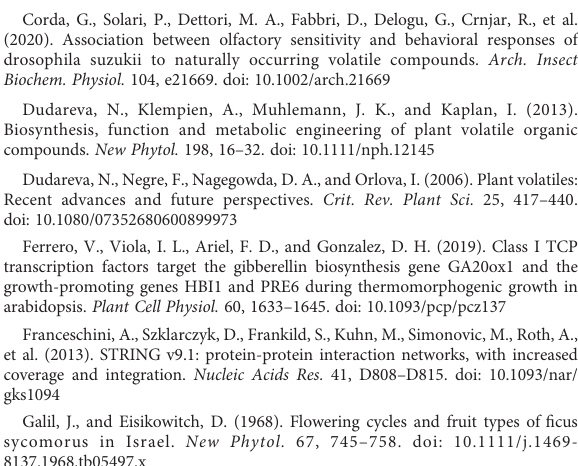
All samples were analyzed by principal component analysis (PCA) and coef fi cient of variance (CV). (A) PCA of the proteome data in a 2D graph of PC1 and PC2. The plot shows the effectfor A-phase (CuA), B-phase (CuB). CuA and CuB represent A phase and B phase of F. hirta bracts, respectively. (B) Display of reproducibility CV of all samples.